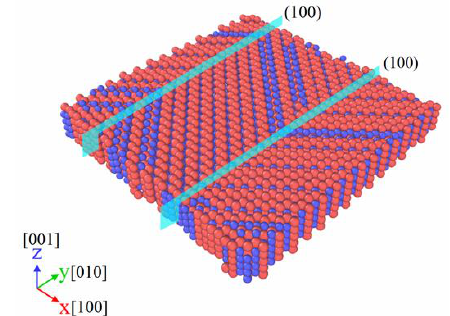
Figure 6. Crystal structure of martensitic twins with a (100) twin plane.